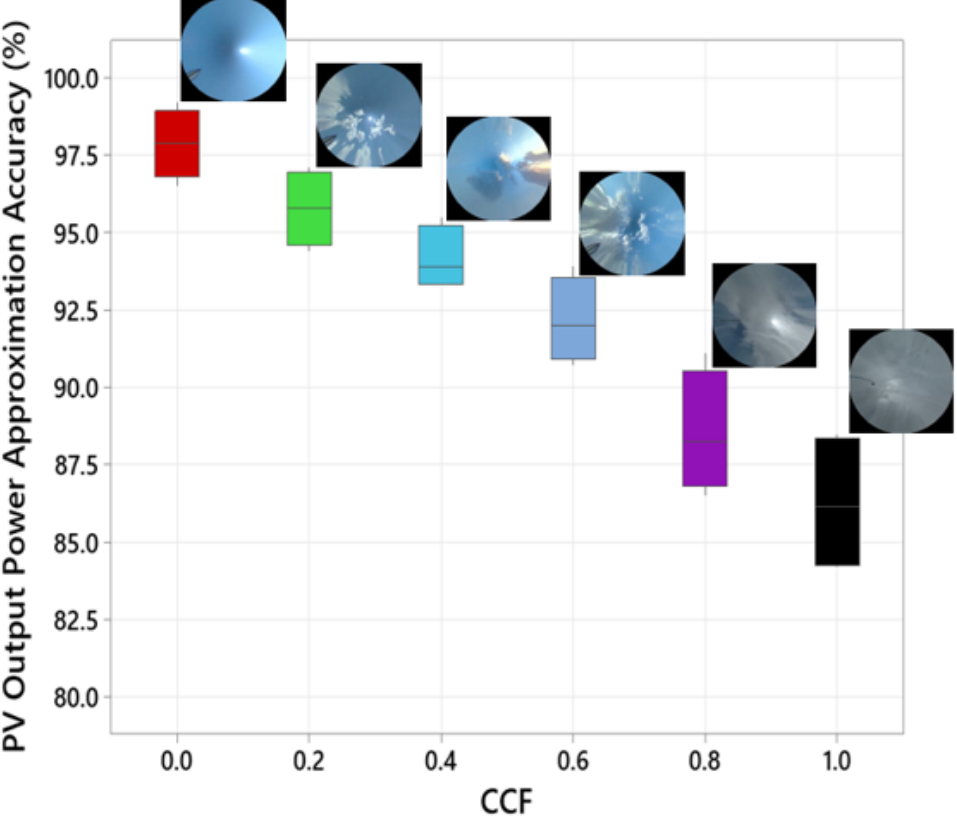
Figure 9. CCF versus the accuracy of the PV output power prediction.